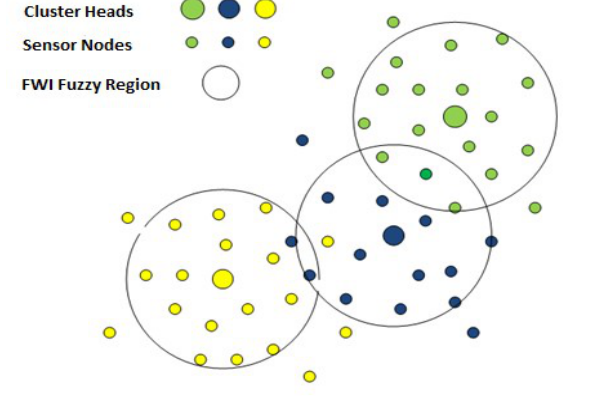
Figure 1. Spatial map of weather variables and the fire weather index